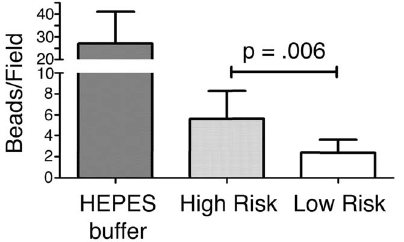
Figure 6. Summary. In women at high risk of preterm birth (with a short and dilated cervix), we find that the cervical mucus does display spinnbarkeit, is more weakly cross-linked and is a less effective barrier.